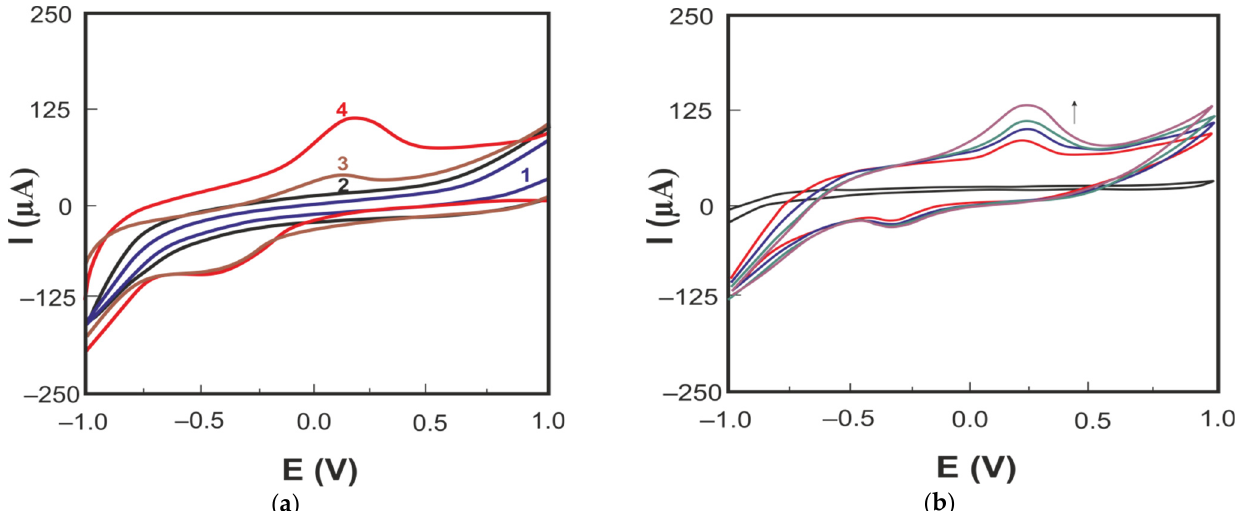
Figure 5. ( a ) Cyclic voltammograms of carbaryl (30 mg/L in 96% ethanol and deionized water (1:1)) on the LRGO plane electrode (curve 3) in the background electrolyte PBS (pH 6.86) (curve 1) and on the LRGO grid electrode (curve 4) in the background electrolyte PBS (pH 6.86) (curve 2); ( b ) cyclic voltammograms of carbaryl (30 mg/L in 96% ethanol and deionized water (1:1)) on the LRGO grid electrode in background electrolyte PBS (pH 6.86) (black curve) at different scan rates (0.2; 0.3; 0.4; 0.5 V/s).